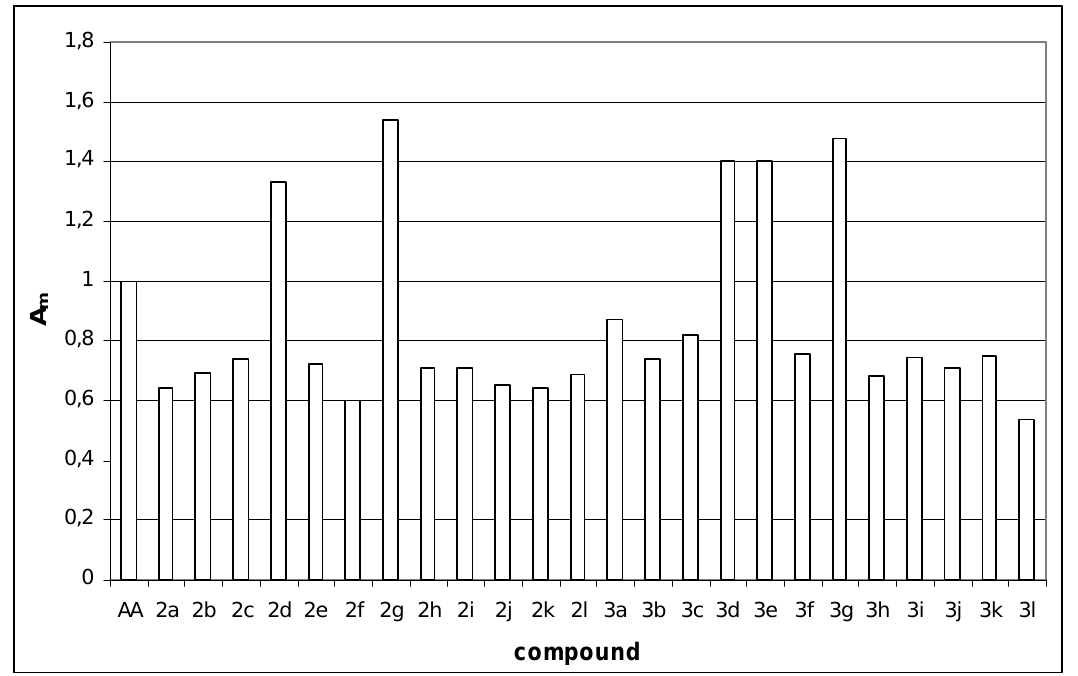
Figure 1. Antioxidant activities of novel coumarin derivatives relative to ascorbic acid ( A – activity relative to ascorbic acid (AA) on a molar